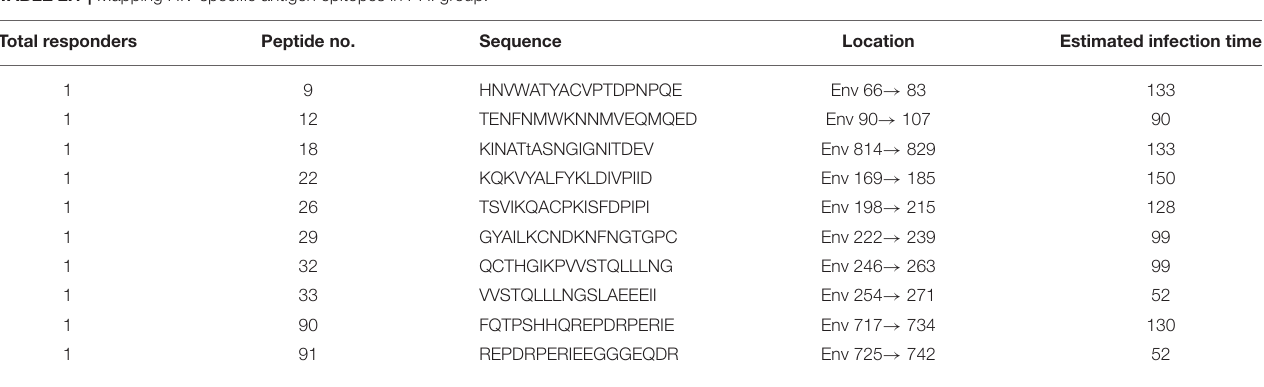
TABLE 2.1 | Mapping HIV-specific antigen epitopes in PHI